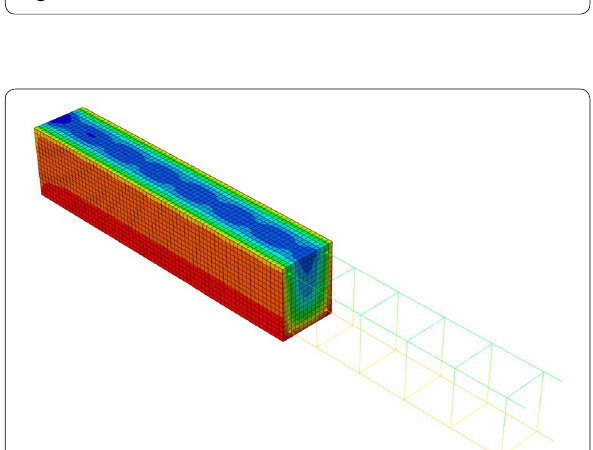
Fig. 9 ISO-834 fire curve